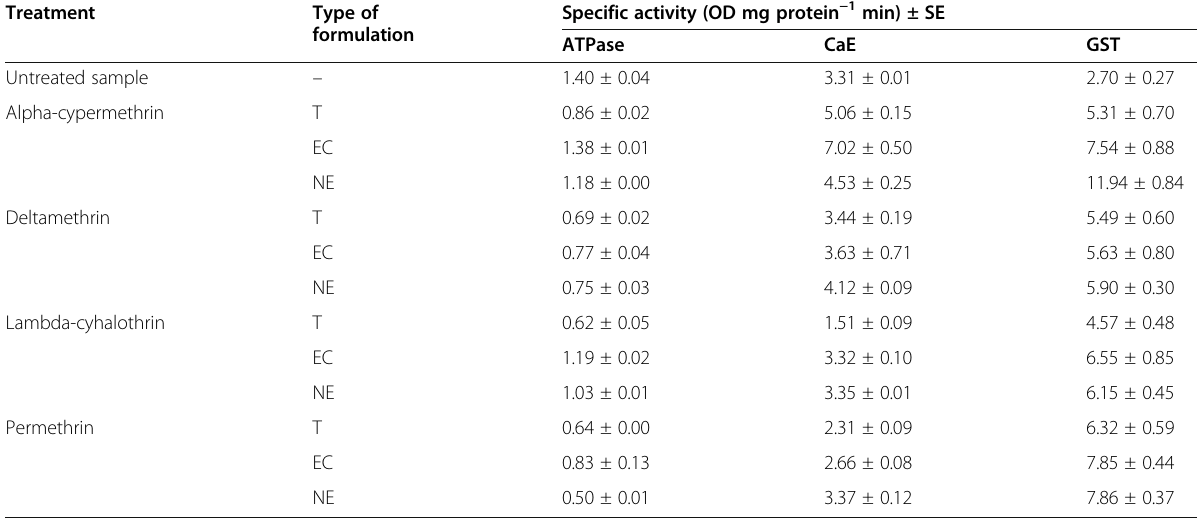
Table 3 Biochemical effects of tested pyrethroids on some enzymes activity in C. pipiens larvae after 24 h of the treatment with LC 50 of each compound